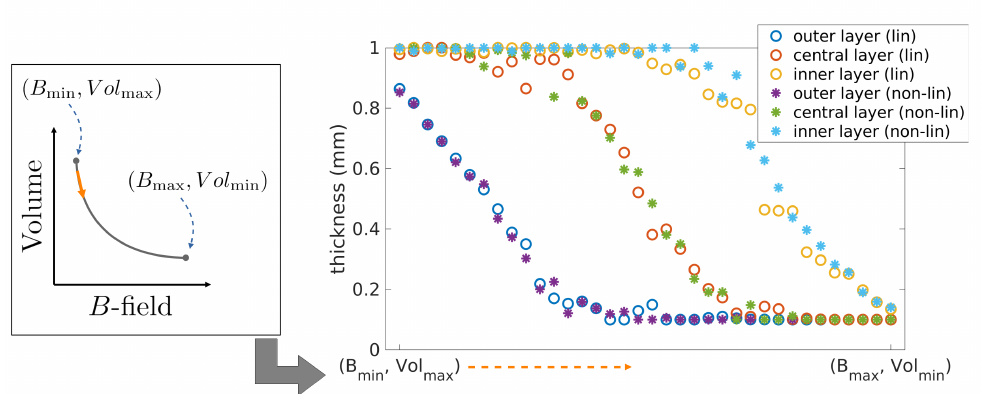
Figure 10. Thickness values of the three layers obtained from linear and nonlinear assumption, corresponding to the Pareto front solutions, listed in the x -axis from the point ( B min , Vol max ) to the point ( B max , Vol min ), as shown by the orange